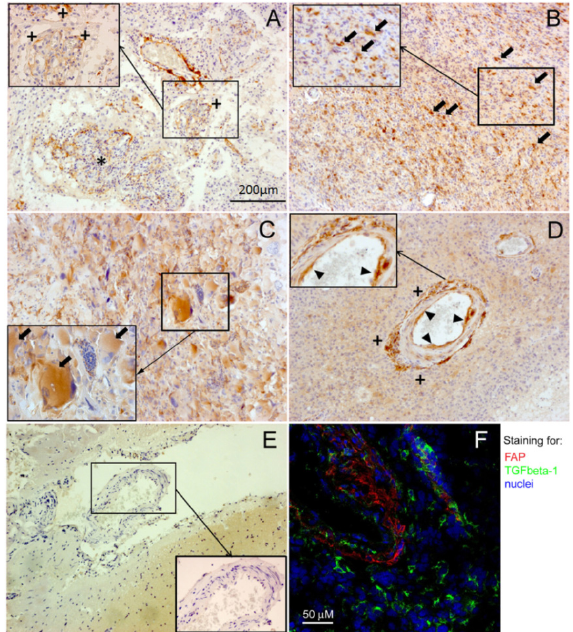
Figure 3. Immunohistochemical detection of FAP and TGFbeta-1 in the tumor microenvironment of human glioblastomas (GBMs). ( A – D ) Representative images of FAP immunopositivity (brown) in GBMs as compared to ( E ) non-tumorous brain tissue (pharmacoresistant epilepsy), where no FAP immunostaining was detected. In GBMs, FAP is expressed in perivascular stromal cells (+), including microvascular proliferations (*), and in some tumors also in some cancer cells (arrows). Infrequently, FAP was also detected in the endothelial cells of blood vessels (arrowheads showing endothelial FAP in an arteriole). ( F ) Representative confocal fluorescence microscopy image of a GBM tissue section showing TGFbeta-1 immunopositivity (green) in the tumor parenchyma and stromal regions in the vicinity of FAP expressing perivascular stromal cells (red). Nuclei (blue) were counterstained with the Hoechst 33258 dye.